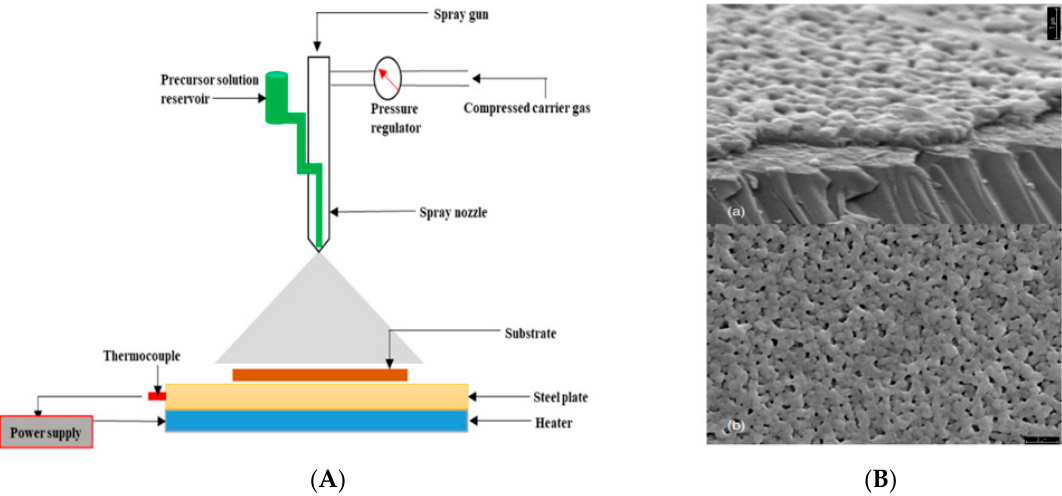
Figure 8. ( A ) Schematics of the chemical spray pyrolysis set up, ( B ) (a) Cross-section SEM image of an Nb 2 O 5 film on glass and (b) SEM image of the surface of an Nb 2 O 5 film on fused silica, both deposited by 30 min spraying and substrate temperature of 350 °C. Reprinted with permission from [99]. Copyright 2004 Wiley.